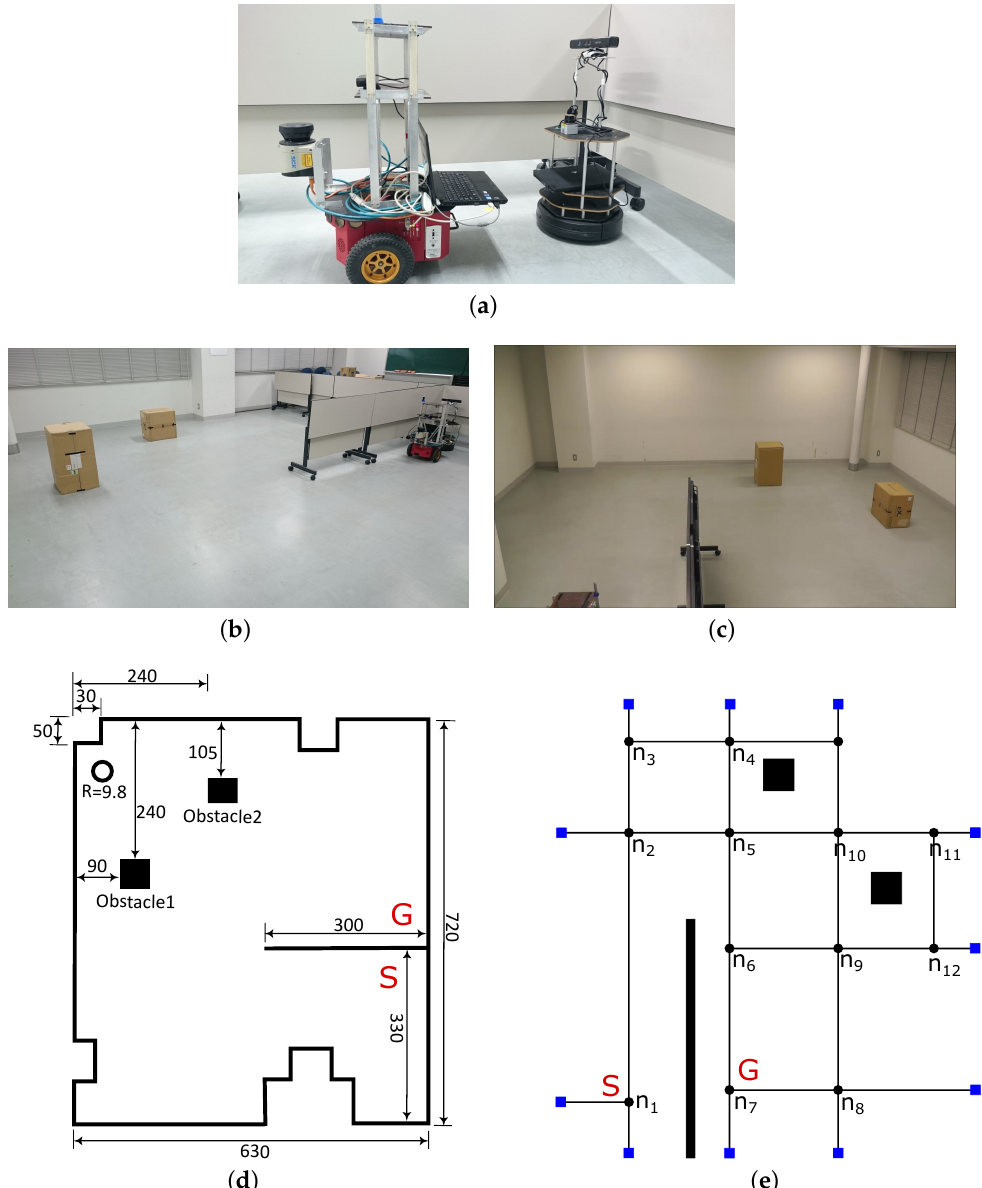
Figure 9. Experiment setup. ( a ) Differential drive robots Kobuki-Turtlebot2 and Pioneer-P3Dx. ( b ) Environment with initial position of robots. ( c ) Another view of the environment. ( d ) Environment dimensions. ( e ) Node-map of the environment where S and G are the start and goal